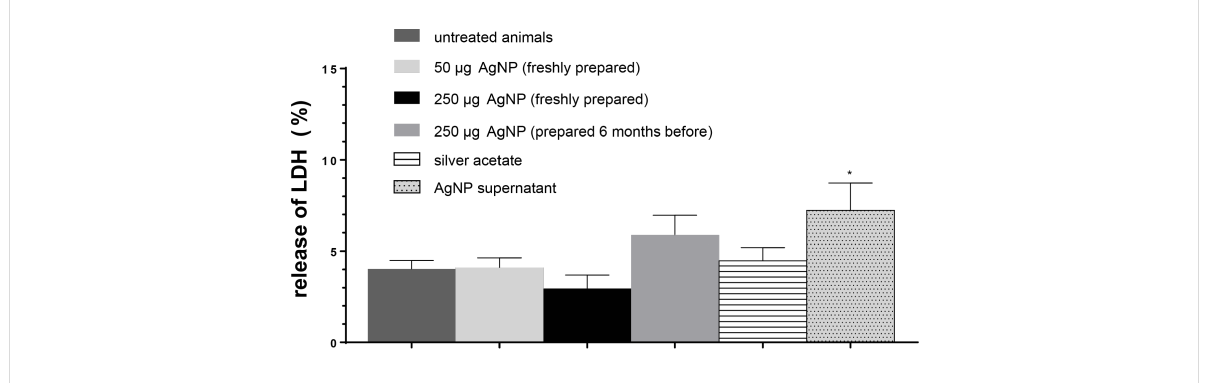
Figure 7: Release of LDH in the supernatant after incubation of PCLS in tissue culture medium for 4 h. The animals had been treated 24 h before either with 50 or 250 µg AgNP (freshly prepared or six months old) or silver acetate (250 µg Ag + ) or AgNP-free supernatant after centrifugation of AgNP. The percentage of total LDH-release from PCLS lysed with Triton X-100 is displayed. Data are represented as mean values ± standard errors of the mean (SEM), with a sample size of n = 4.